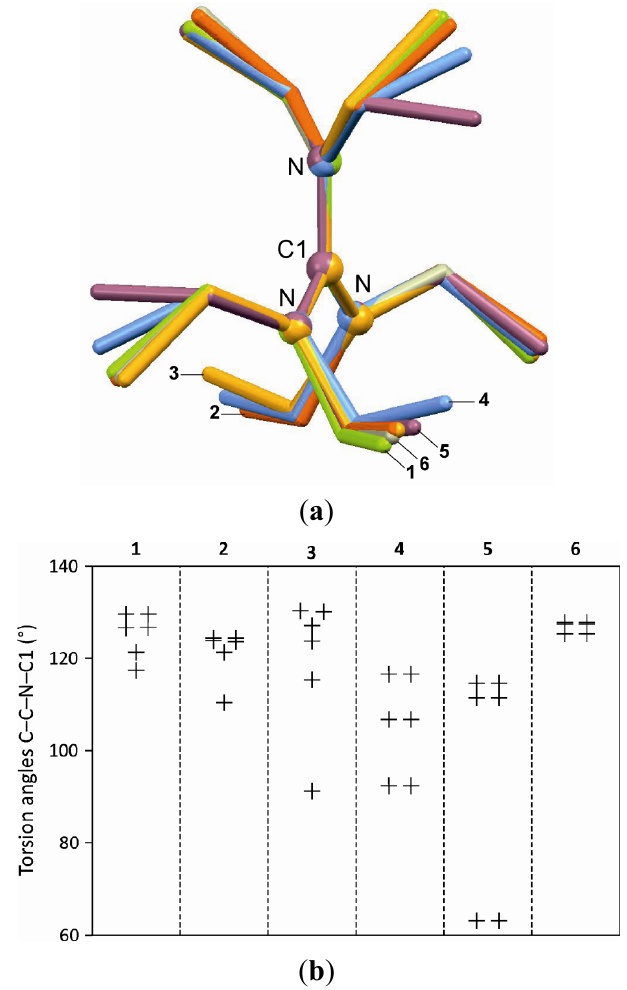
Figure 1. ( a ) Overlay of the hexaethylguanidinium cations (least-squares fits of the central C 7 N 3 fragments of 1 = green, 2 = orange, 3 = yellow, 4 = blue, 5 = purple, 6 = grey); ( b ) Torsion angles C–C–N–C1 describing the conformation of the six ethyl groups in the cations of 1 – 6